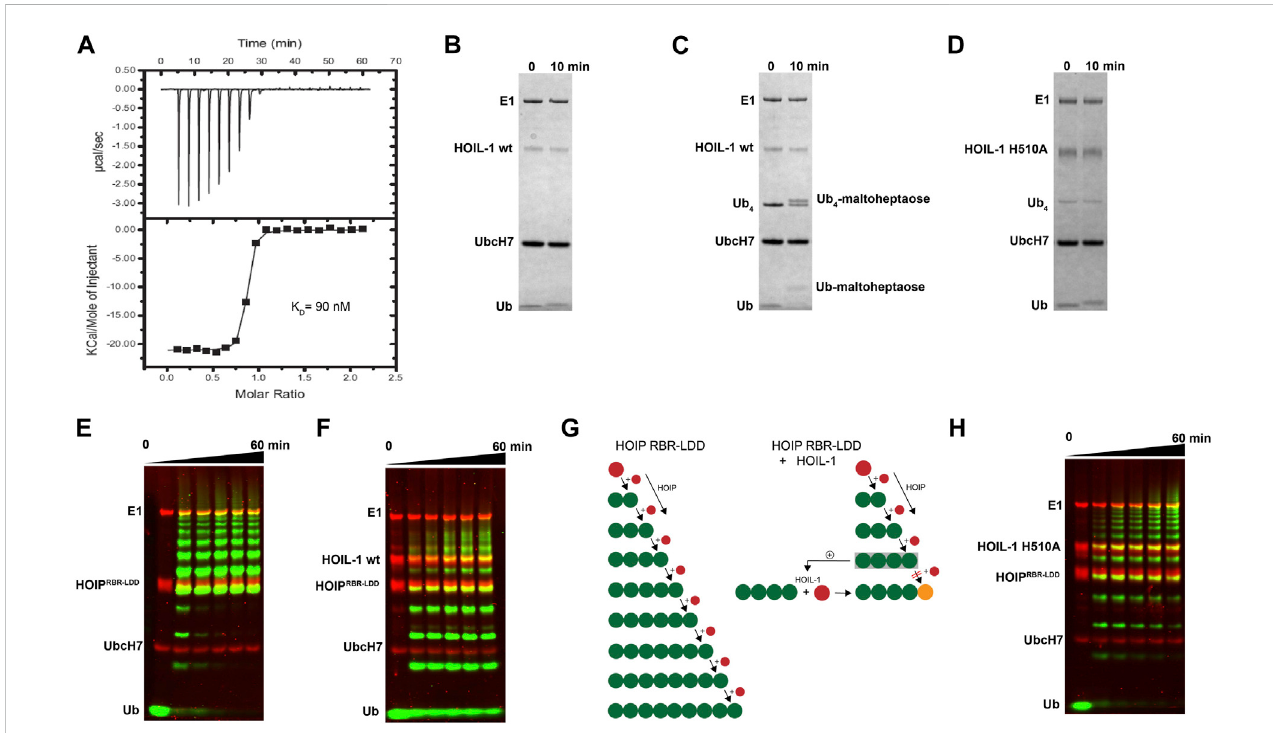
FIGURE 1 Invitro reconstitution ofHOIL-1ubiquitylationactivity. (A) QuantitativemeasurementofHOIL-1bindingtolinear Ub ubiquitylationofHOIL-1intheabsence (B) andpresence (C) oflineartetraUb. (D) ThemutationH510AabolishescarbohydrateubiquitylationofHOIL-1. (E) In vitro reconstitutionofHOIP-RBR-LDD(residues697 – 1072)ligaseactivity. (F) ThelinearubiquitinchainsynthesisactivityofHOIP-RBR-LDDisrestrictedinthe presence of HOIL-1 wt. (G) The ubiquitylation activities of HOIP-LDD and HOIL-1 are schematically illustrated with mono-Ub in red, linear Ub in green and ester linked Ub in orange. HOIL-1 is stimulated by linear tetra Ub as indicated by a plus symbol. (H) HOIP-LDD mediated linear Ub chain synthesis is re- established in the presence of HOIL-1